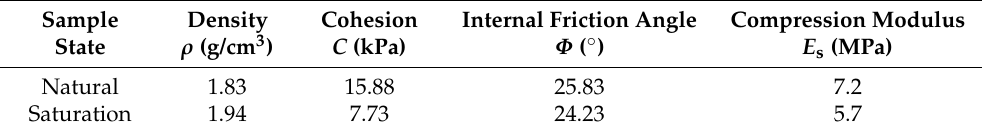
Table 5. Calculation parameters of the soil mass.